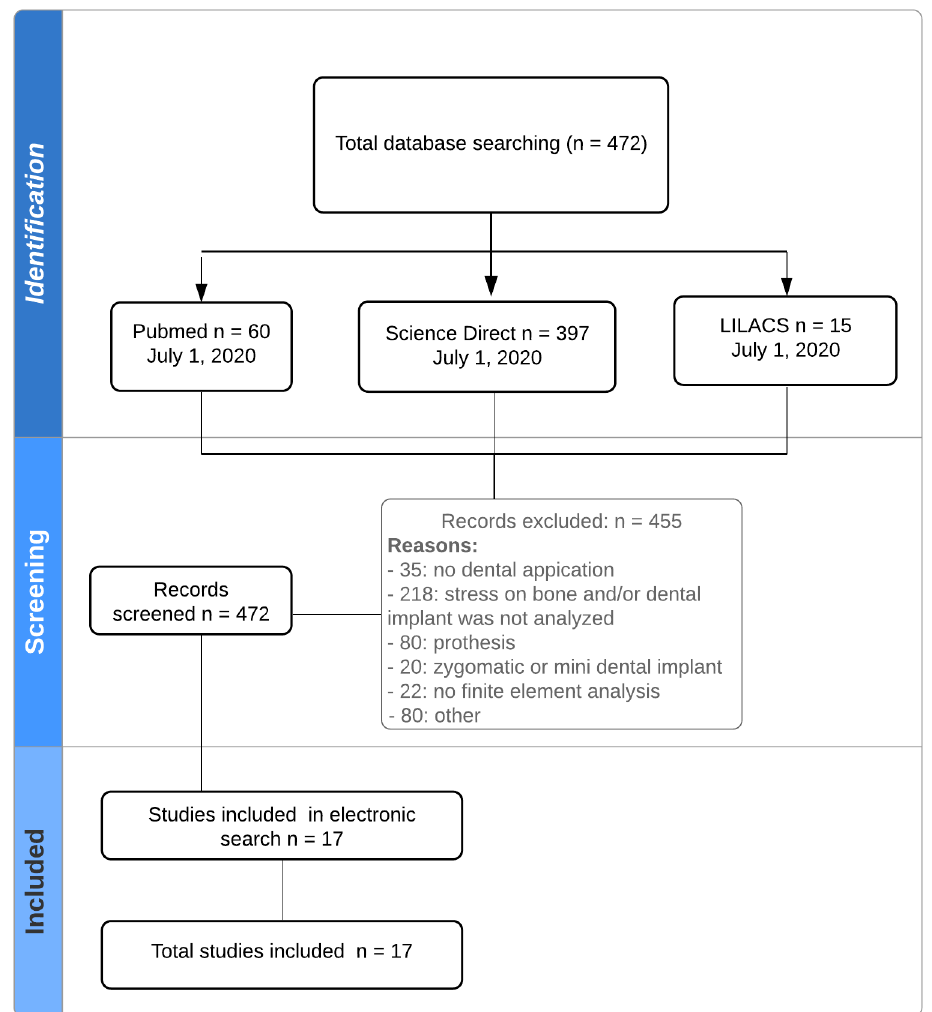
Figure 1. Flowchart. Figure 1.